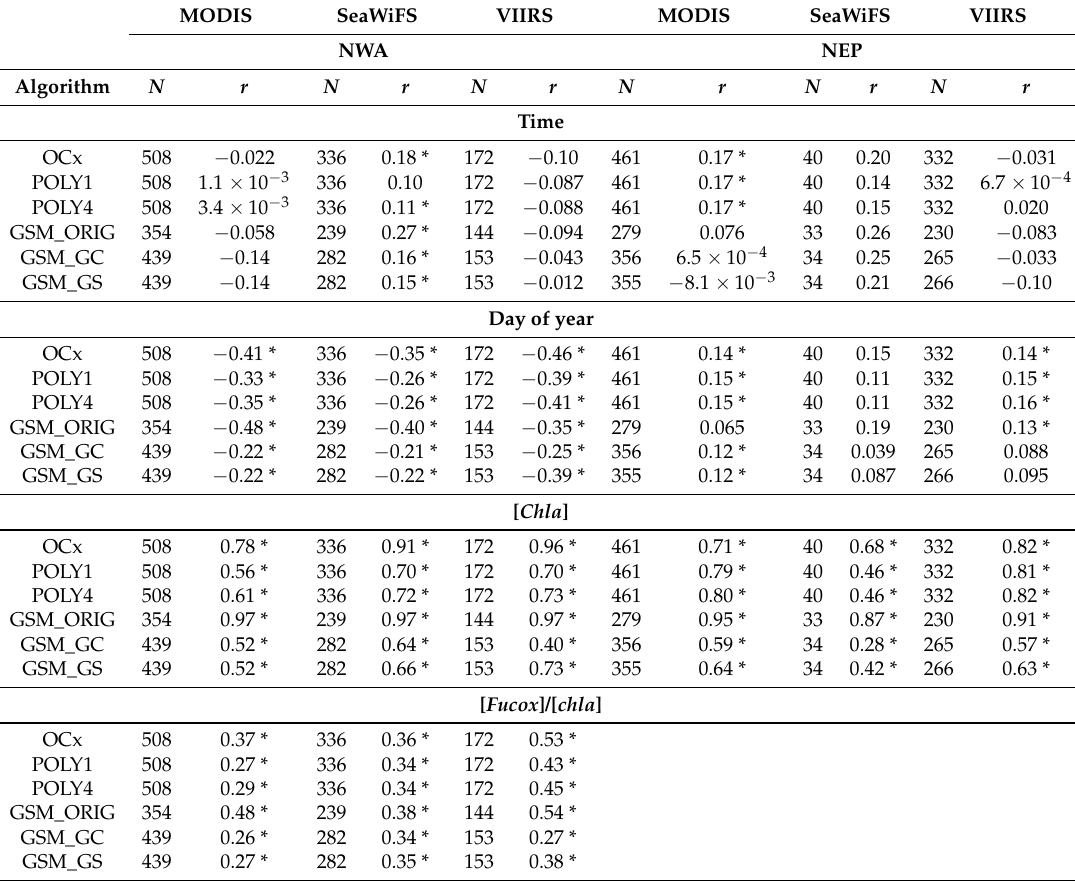
Table 5. Pearson’s correlation coefficients ( r ) from the test for correlation between | E chla | and phytoplankton composition and time (see Section 2.6). * = statistically significant ( p -value <